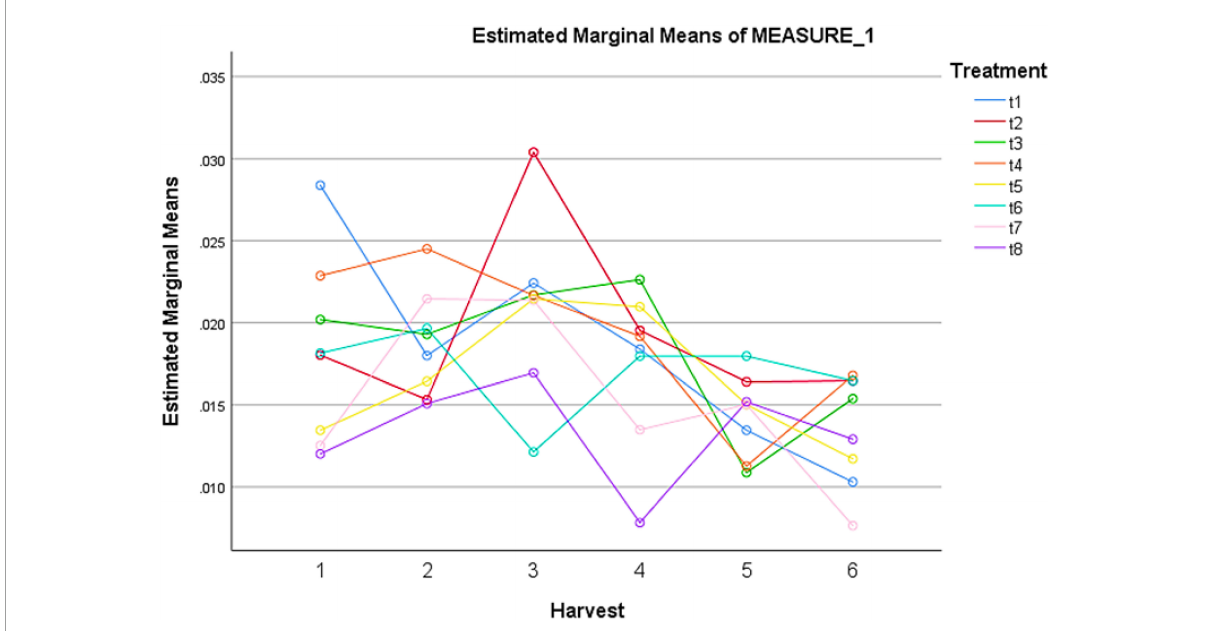
FIGURE2 Effect of different treatments of elicitors on flavonoid content of Silybum marianum in hydroponics. The harvest time is on x -axis; 1 = 24 h, 2 = 48 h, 3 = 72 h, 4 = 96 h, 5 = 120 h, 6 = 144 h. For different treatments, t1 = control, t2 = methyl jasmonate, t3 = silver nanoparticles, t4 = fungal elicitors, t5 = methyl jasmonate + fungal elicitors, t6 = methyl jasmonate + silver nanoparticles, t7 = fungal elicitors + Silver nanoparticles, t8 = methyl jasmonate + silver nanoparticles + fungal elicitors.